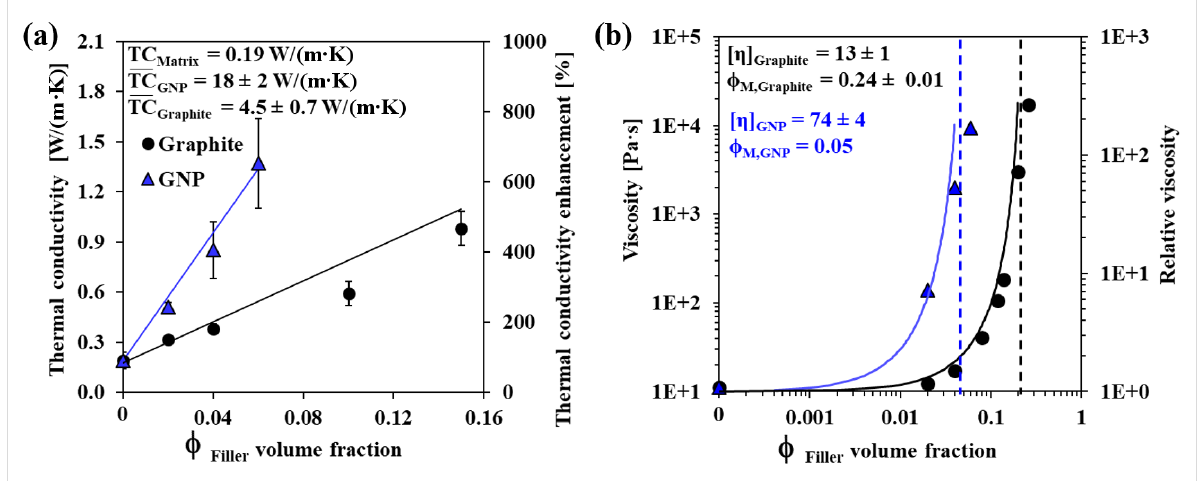
Figure 2: Single-filler composites: (a) TC and (b) viscosity and relative viscosity as functions of filler type and volume fraction at constant shear rate (0.1 1/s) and temperature of 25 °C. Each graph displays the fitting parameters. The solid lines in (a) are fits to the ROM model (Equation 1), and those in (b), to the Krieger–Dougherty model (Equation 2). The dashed lines in (b) represent the critical volume fraction, φ M , found by fitting to the Krieger–Dougherty (K–D) model (Equation 2). Some error bars are hidden by the data symbols due to small measurement errors.